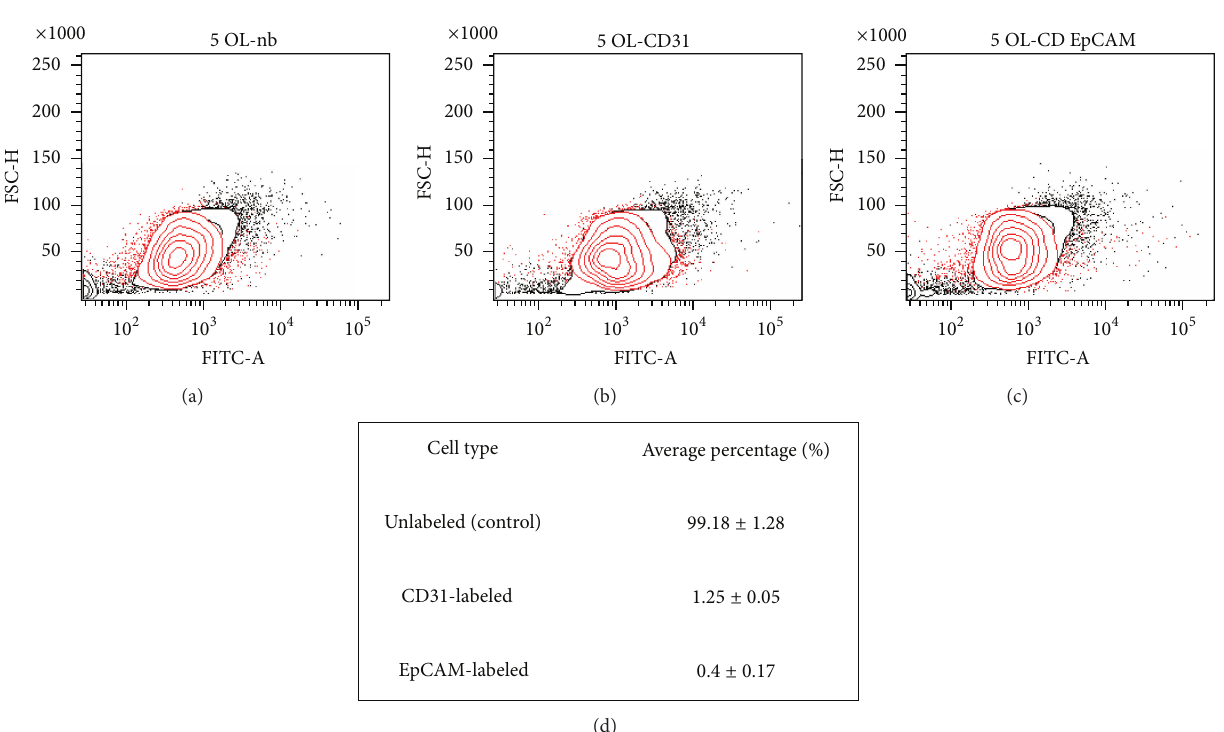
cultures previously incubated with BPA 1 nM ( 𝑃 < 0.05 R versus